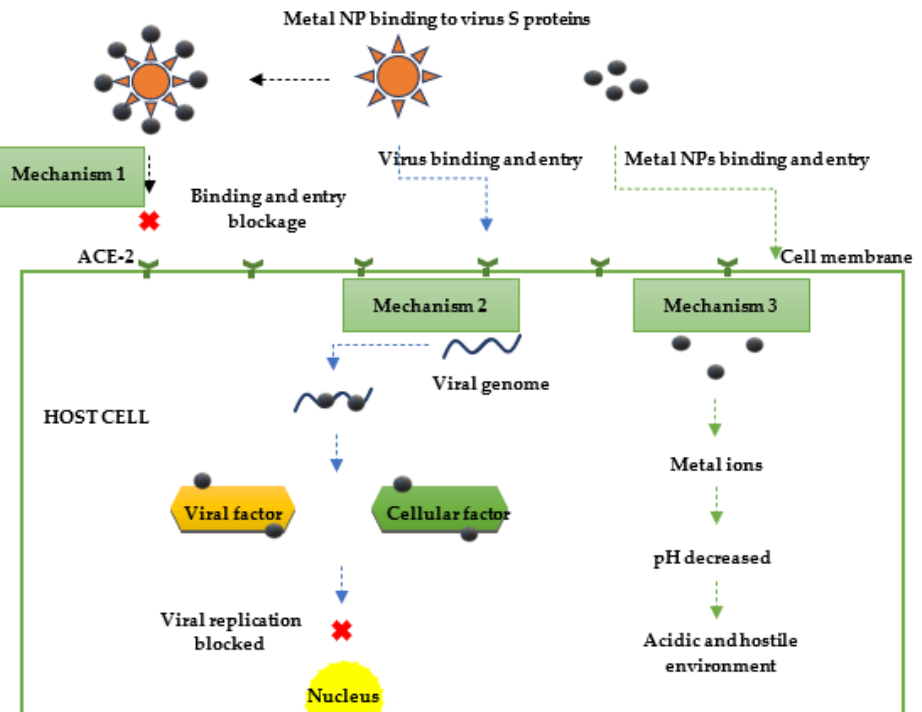
Figure 4. Possible antiviral mechanisms of metal nanoparticles.